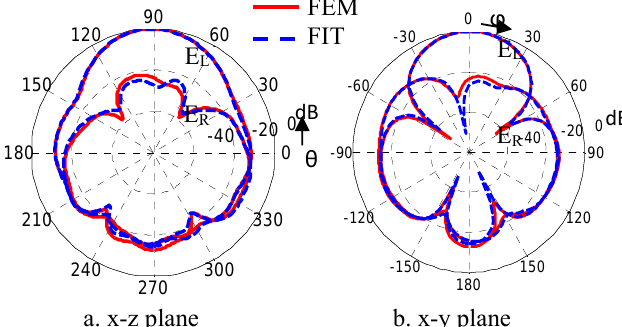
Fig.13. The circular polarization radiation pattern components of the 2×2 circularly polarized DRA array elements mounted on a cylindrical ground plane in free space, at f=5.8 GHz.